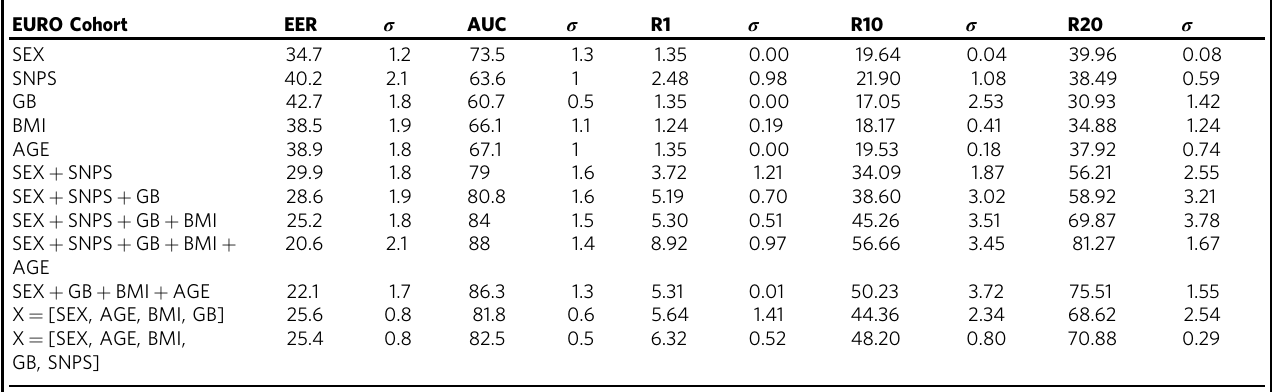
Table 3 Average identi fi cation and veri fi cation results for the EURO cohort EURO